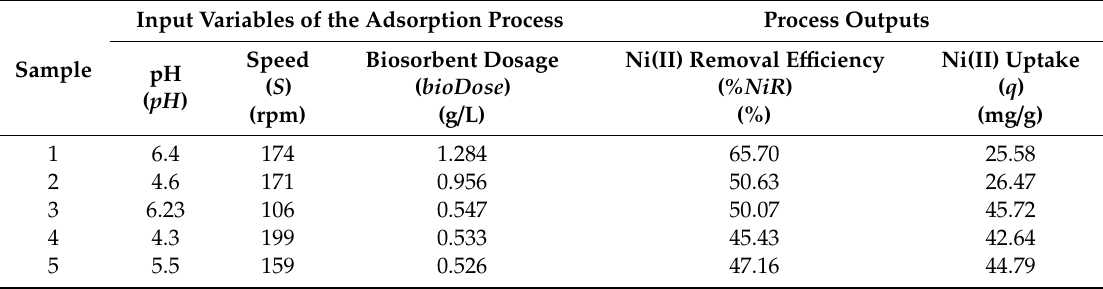
Table 6. Test matrix of the Ni(II) biosorption process.